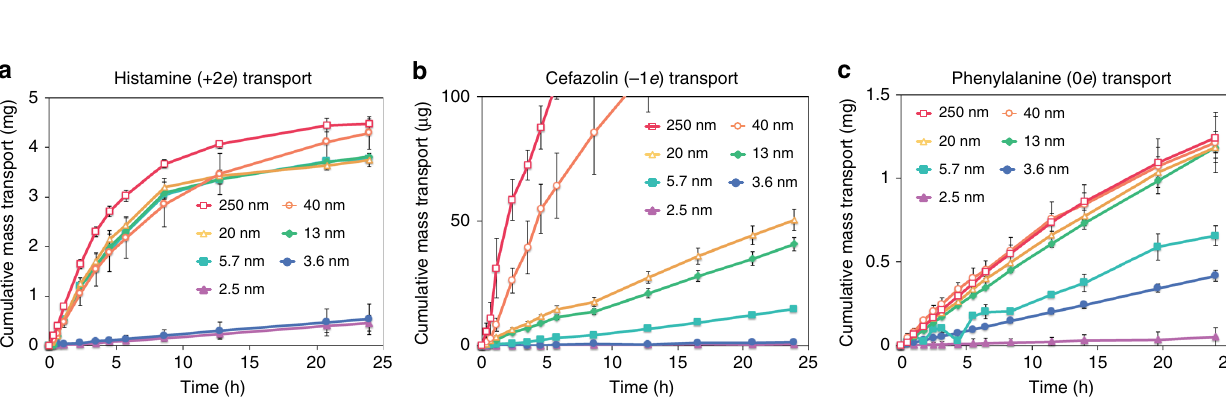
Fig. 2 Drug transport through nanochannels. Cumulative diffusive mass transport of histamine (positive) ( a ), cefazolin (negative) ( b ), and phenylalanine (neutral) ( c ), chosen as representative of the three different charge states. Release curves are measured for a scaled series of nanochannels over 24 h. The released molecules were dissolved in a 50 mM NaCl aqueous solution within a dual reservoir system housing source and drain chambers separated by a nanochannel membrane. The concentration of molecule released from the source into the sink reservoir was measured via UV spectrophotometry. Each of the data points denotes the average of three individual replicates, error bars are